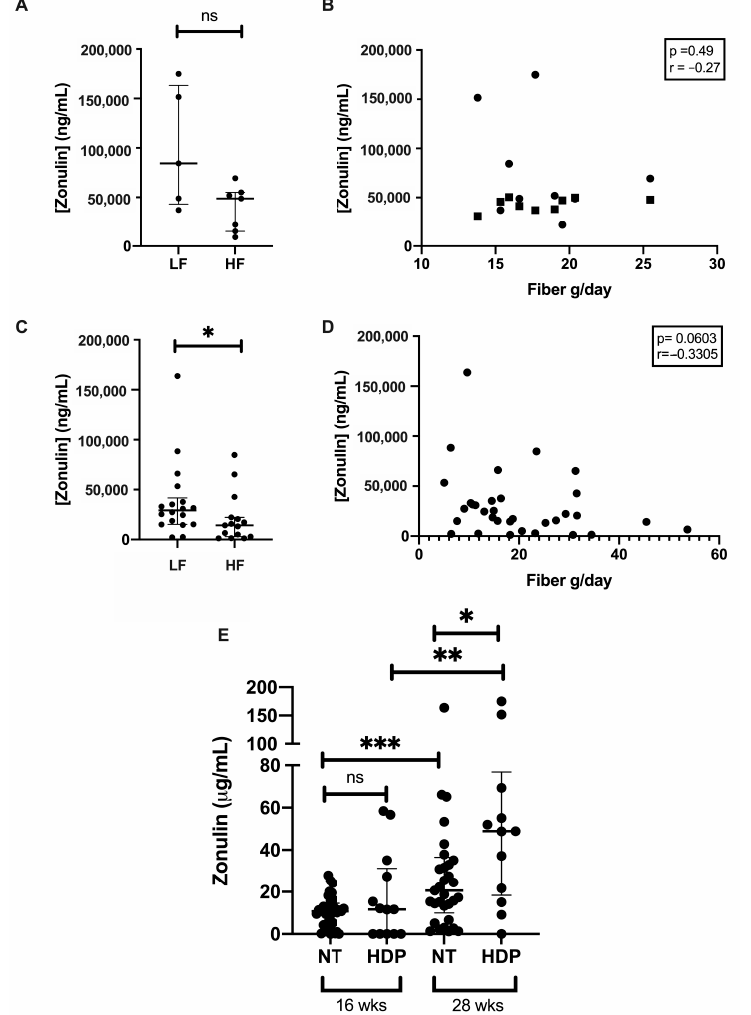
Figure 4. Serum zonulin concentrations in HDP and NT pregnancies baseline and 28 weeks gestation. Serum zonulin concentrations in lower (LF) and higher fiber (HF) groups in future HDP ( A ) and NT women ( C ). ( B ) Correlation of dietary fiber intake and zonulin concentrations in HDP ( B ) and NT women ( D ). ( E ) Serum zonulin concentration in HDP and NT pregnancies at baseline and 28 weeks gestation. HDP = Hypertensive disorders of pregnancy. NT = Normotensive. * = p < 0.05, ** = p < 0.01, *** = p <